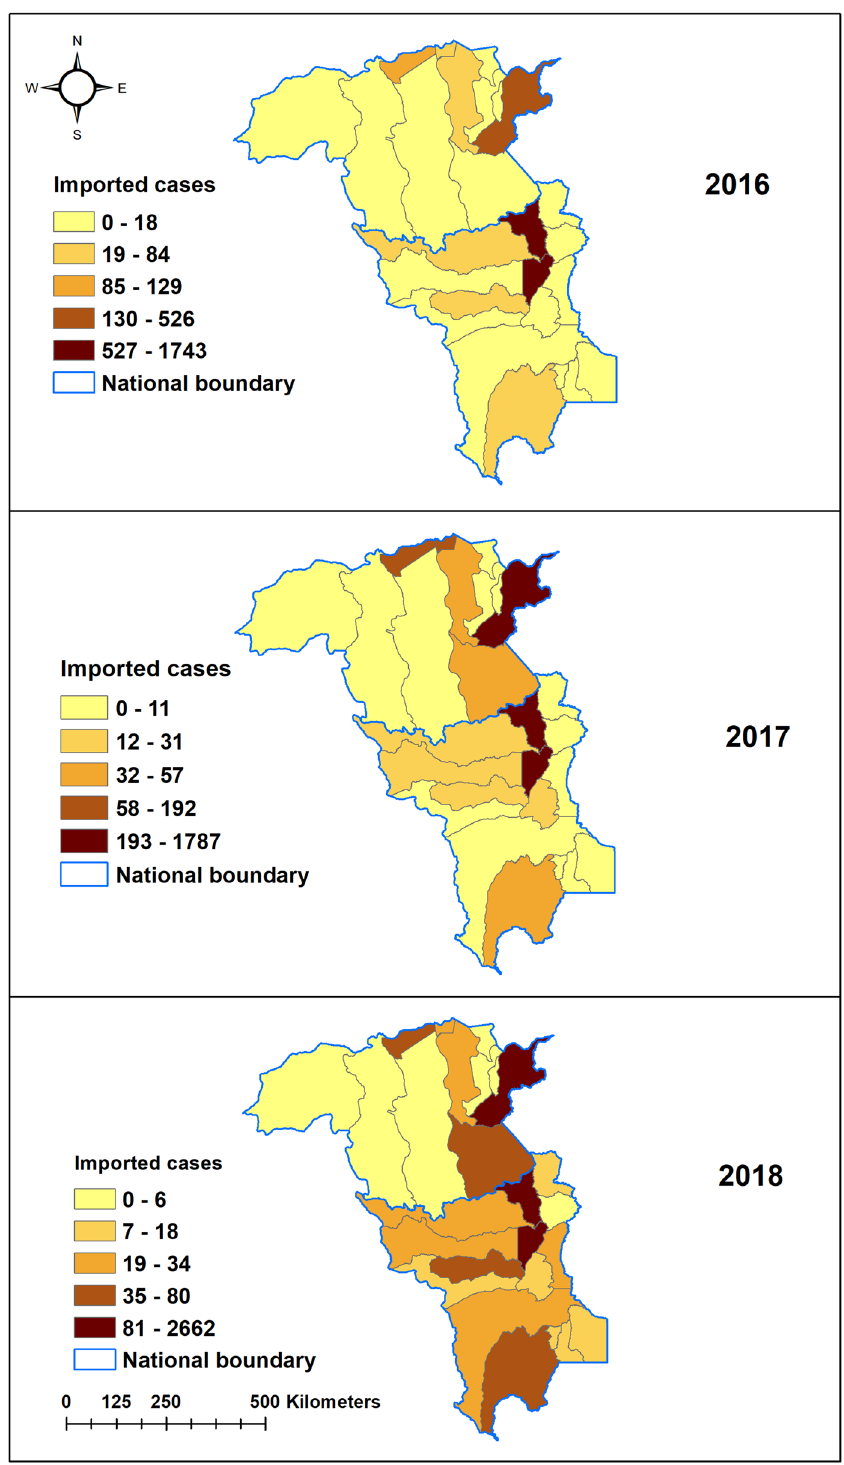
Figure 4. Imported malaria cases by municipalities in Roraima and Bolivar states,